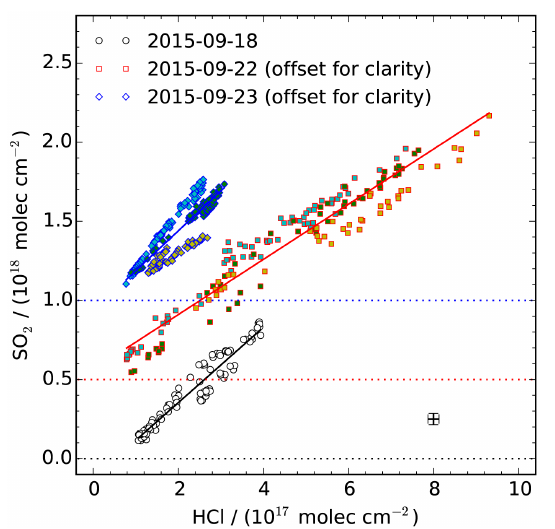
Figure 13. Same as Fig. 10 but for SO 2 and BrO VCDs. For clarity, data on 22 and 23 September are offset in ordinate by 0.5 × 10 18 and 1.0 × 10 18 moleccm − 2 , respectively, as indicated by the col- ored dotted